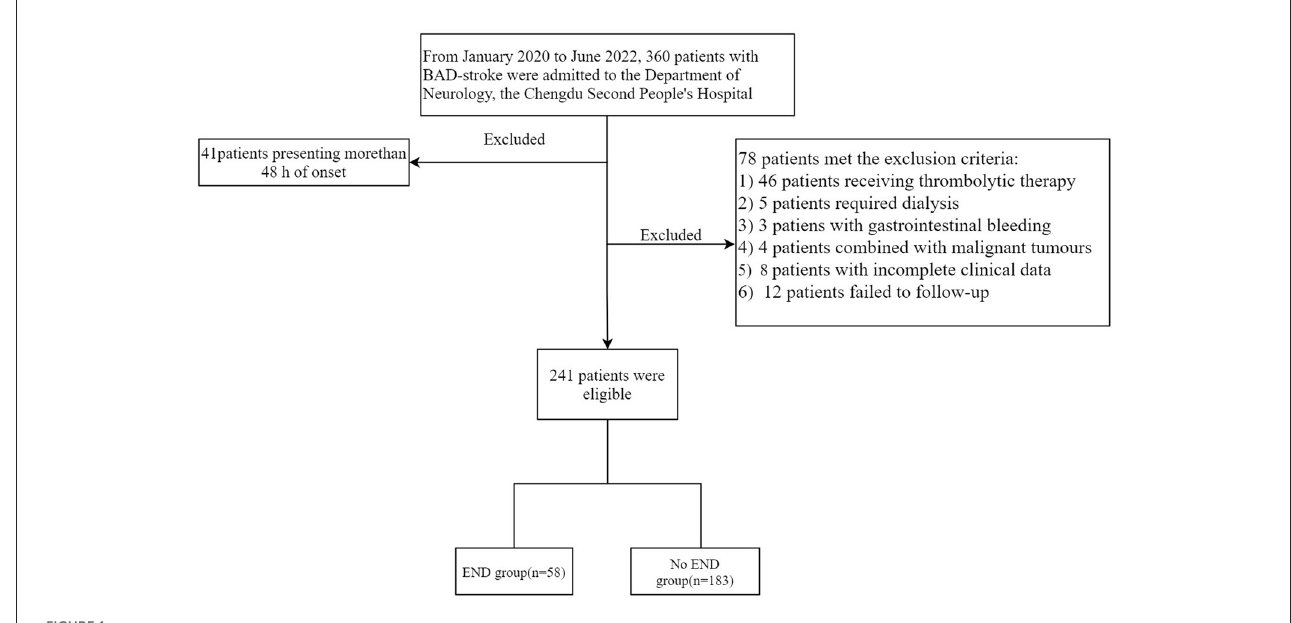
FIGURE1 A flow chart for the patients’ screening.